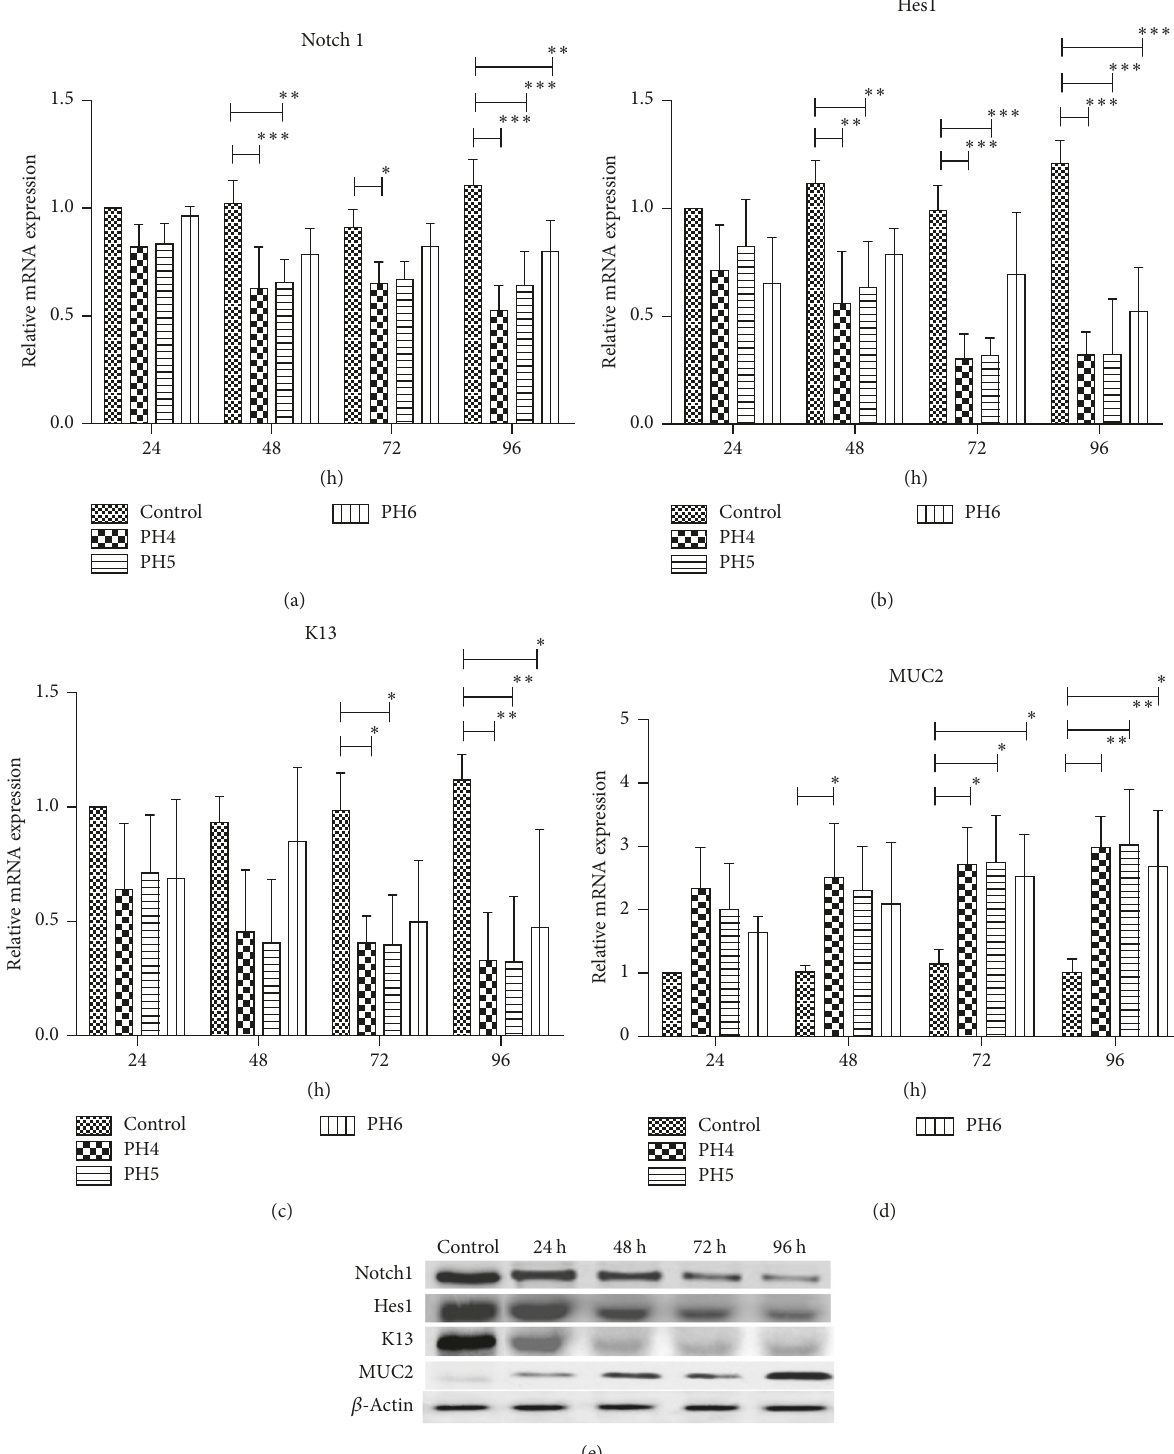
Figure 5: Effects of hydrochloric acid on Notch1, Hes1, K13, and MUC2 expressions. Cells were treated with different concentrations of hydrochloric acid (pH4, pH5, and pH6) for 24 h, 48 h, 72 h, and 96 h, respectively. (a–d) Notch1, Hes1, K13, and MUC2 mRNA expression levels in Het-1A cells exposing to different concentrations of hydrochloric acid for different time periods. ∗ 𝑝 < 0.05 , statistically significant difference. ∗∗ 𝑝 < 0.01 , statistically significant difference. ∗∗∗ 𝑝 < 0.001 , statistically significant difference. (e) Representative western blot results of Notch1, Hes1, K13, and MUC2 protein expressions in Het-1A cells treated with hydrochloric acid (pH5) for different time